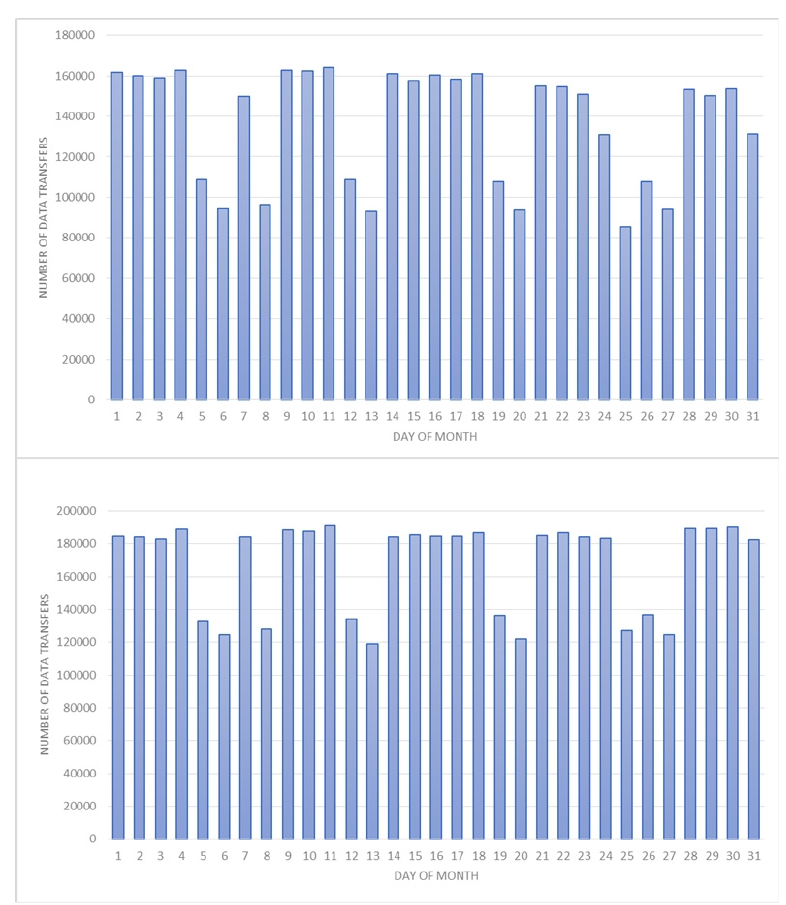
Figure 6. Number of data files transferred between the vehicles of the fleet and the corporate data repositories for the month of December 2015: ( Top ) the files of the production control system; and ( Bottom ) the files of the planning control system. ( Bottom ) the files of the planning control